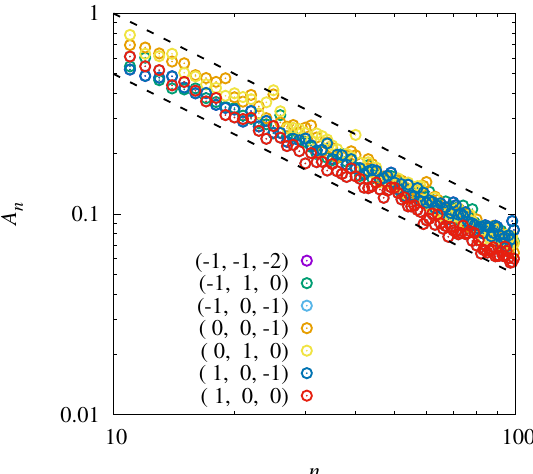
Figure 1. Numerical estimates of the quantity A n plotted as a function of n for seven different choices of the triple ( α , β , γ ) ∈ Z 3 . Note that a logarithmic scale is used for both axes. The two dashed lines represent the curves A n = 5/ n and A n = 10/ n , which suggest that A n = O ( n p ) with p ≈ −